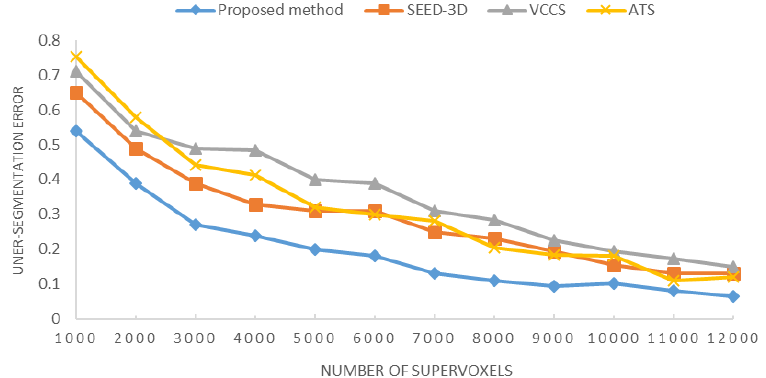
Figure 10. Relationship between under-segmentation error and the number of supervoxels for VCCS